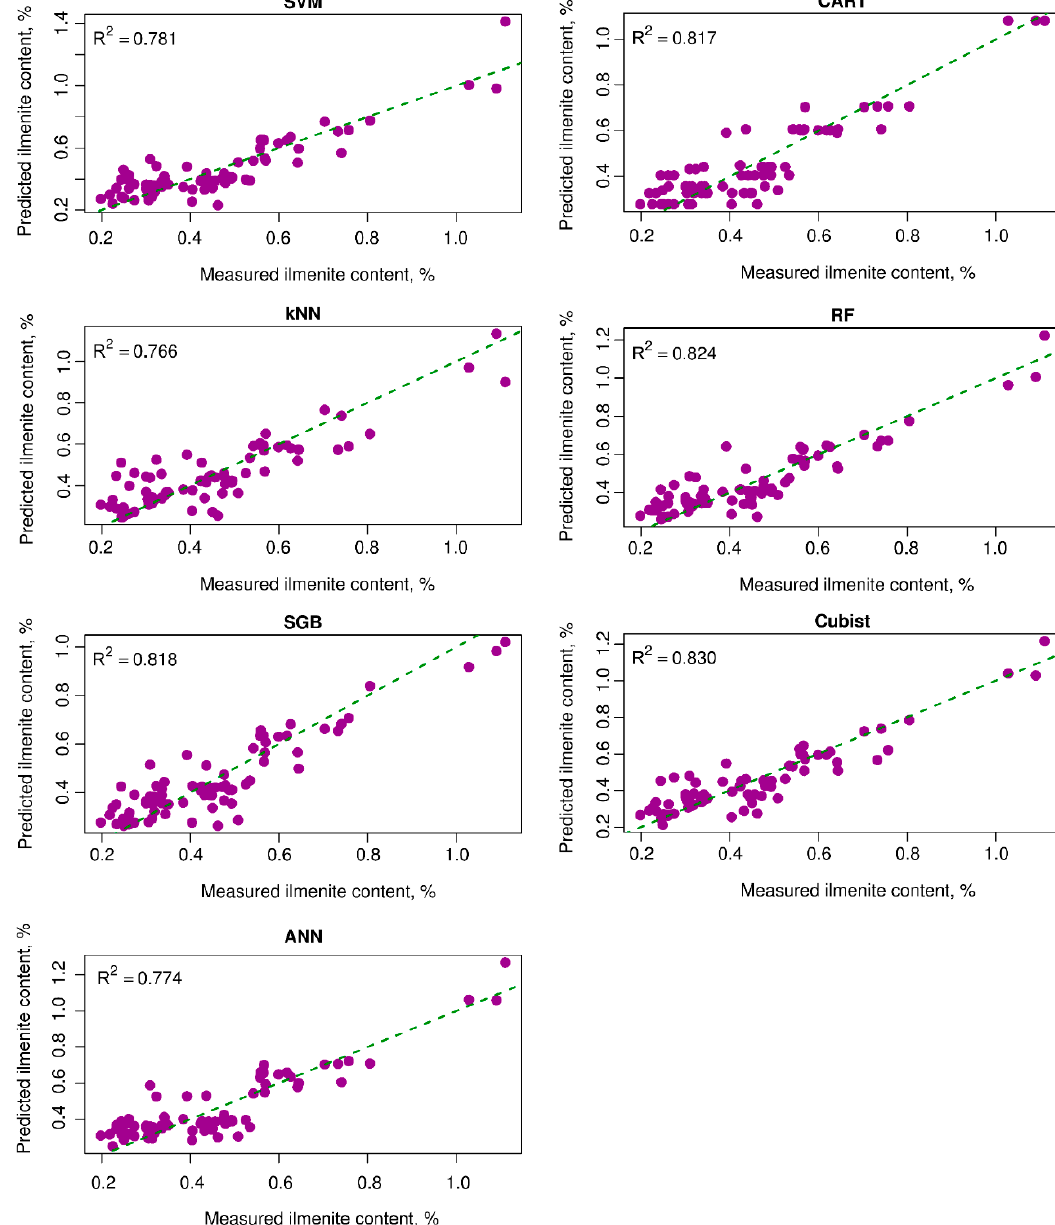
Figure 13. Predicted/measured parameters of the soft computing techniques used herein.